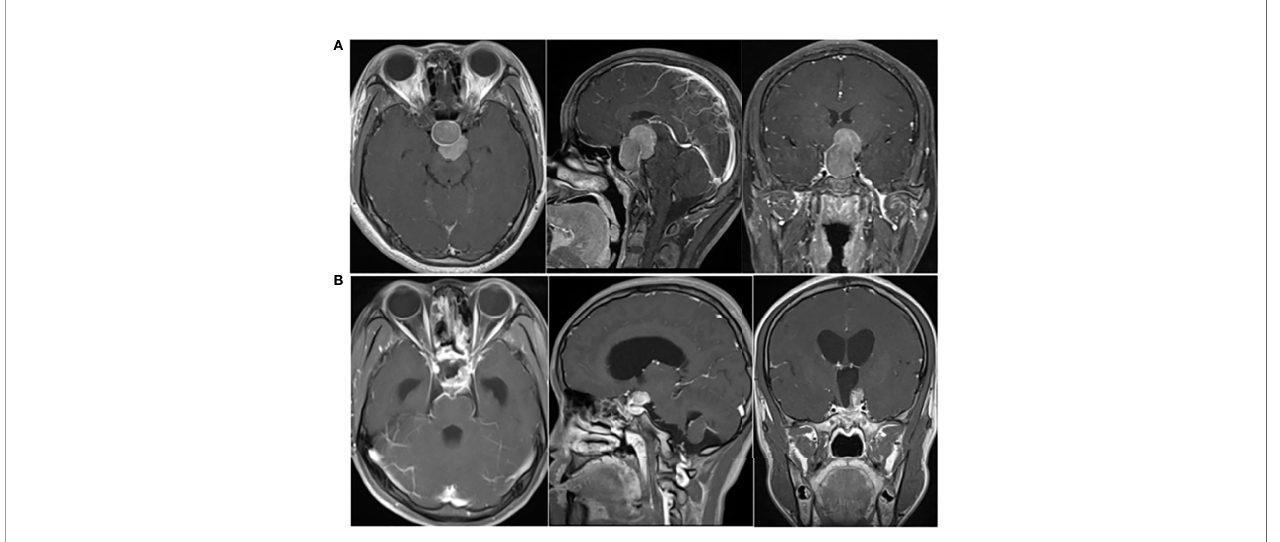
FIGURE 1 | (A) Preoperative pituitary enhanced MRI (April 2016) showed: mass-shaped obvious enhanced signal could be seen in intrasellar and suprasellar area; the lesion extended upward to the suprasellar cistern, and the pituitary stalk was compressed, with the optic chiasm compressed and raised. (B) Postoperative pituitary enhanced MRI (October 2016) indicated: postoperative changes showed in the sellar region; abnormal enhancement of the upper left posterior pituitary appeared, with left cavernous sinus closely